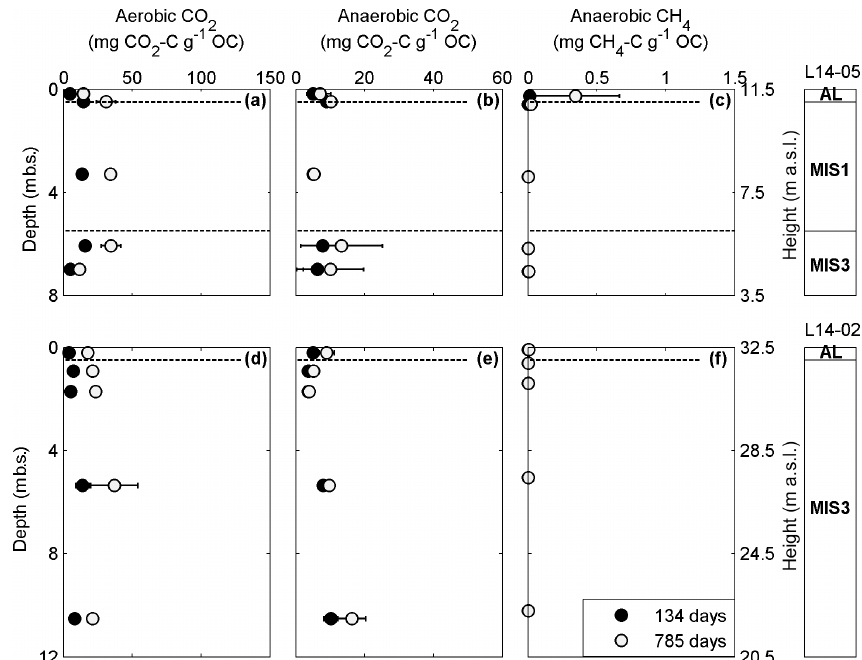
Figure 5. Depth profiles of total aerobic CO 2 (a) , anaerobic CO 2 (b) , and anaerobic CH 4 (c) production per gram of organic carbon (g − 1 OC) in sediment samples from the L14-05 (a–c) , and L14-02 cores (d–f) after 134 (closed symbols) and 785 (open symbols) incubation days at 4 ◦ C for the active layer (AL), which is considered to be 0.5m thick, and permafrost deposits from the Holocene interglacial (MIS 1) and the Kargin interstadial (MIS 3). Data are mean values ( n = 3) and error bars represent 1 standard deviation. Note the different scales. Table 2. Mean ( ± 1 standard deviation) CO 2 and CH 4 production after 134 and 785 incubation days. Production after 785 days was not determined (n.d.) for the Muostakh Island sequence. MIS 2 deposits were not present in the sample material from the Buor Khaya Peninsula and Bol’shoy Lyakhovsky Island.